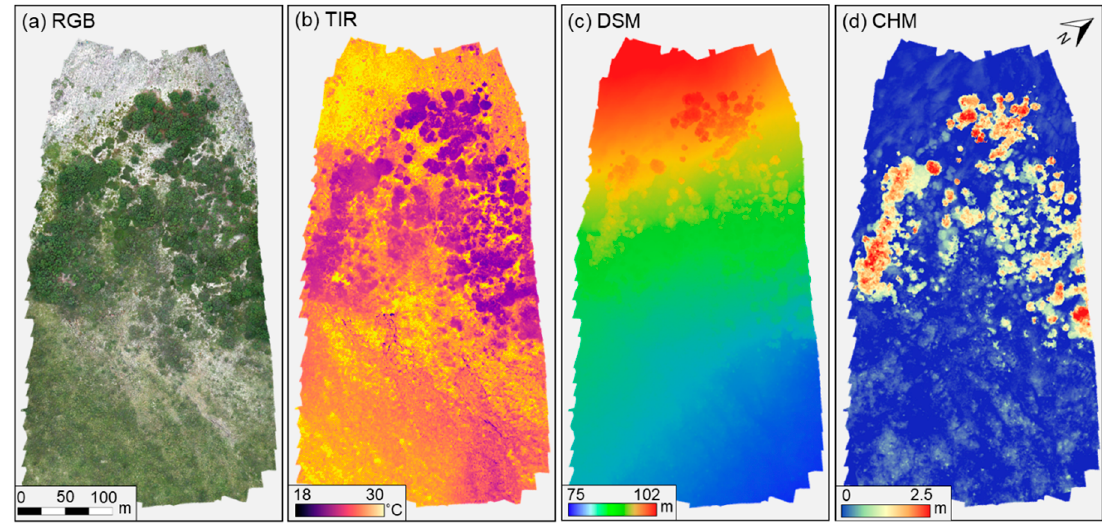
Figure 4. Osprey image products from the case flight at the Kougarok Hillslope field site: ( a ) optical RGB; ( b ) thermal infrared (TIR, i.e., plant ‘skin’ temperature); ( c ) digital surface model (DSM); ( d ) canopy height model (CHM).